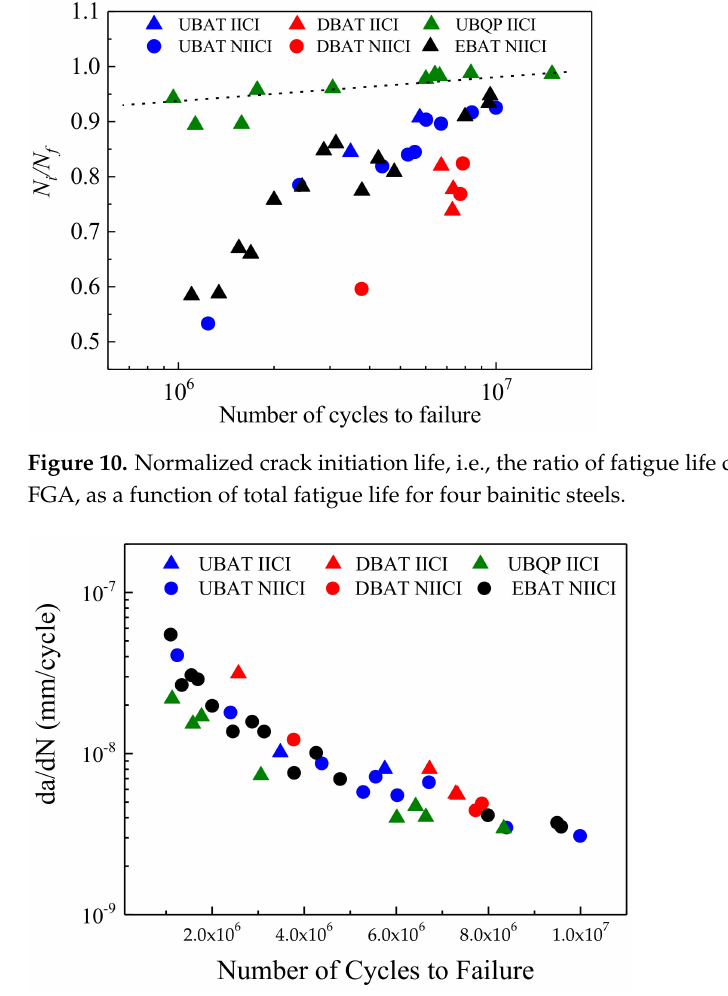
Figure 11. The average crack growth rate within FGA as a function of total fatigue life for four bainitic